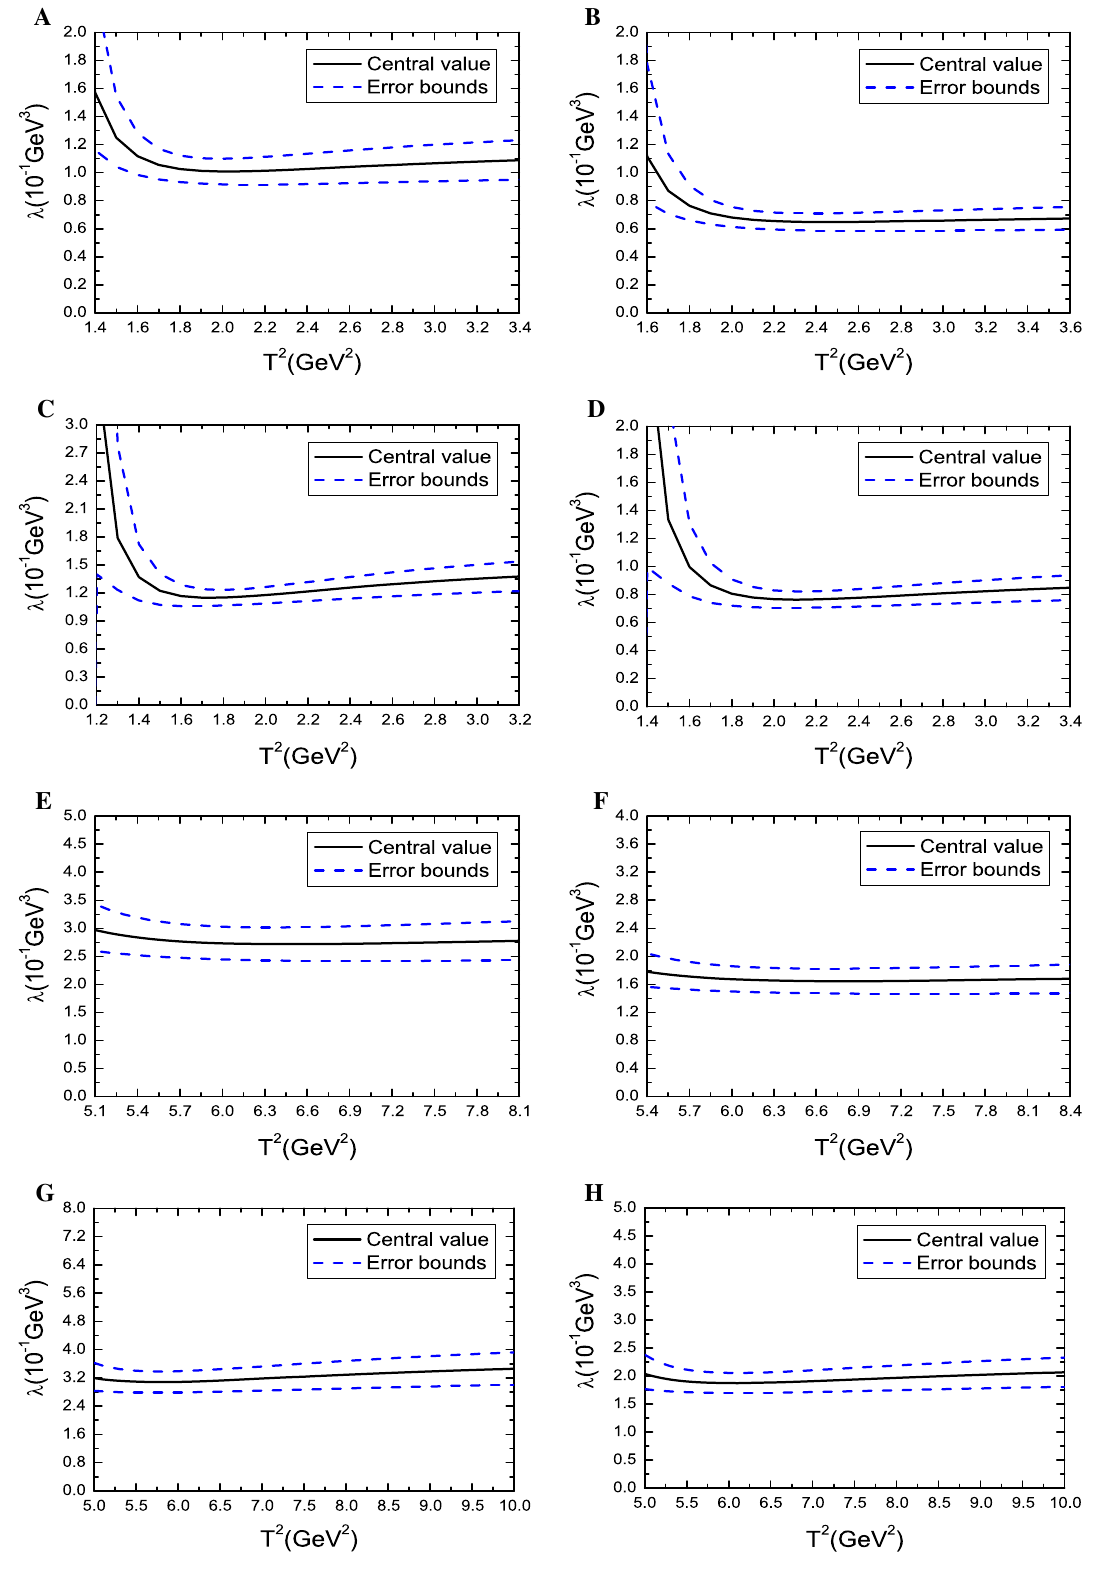
Fig. 6 The pole residues of the doubly heavy baryon states with variations of the Borel parameters T 2 , where the A , B , C , D , E , F , G and H denote the (cid:2) cc , (cid:2) ∗ cc , (cid:10) cc , (cid:10) ∗ cc , (cid:2) bb , (cid:2) ∗